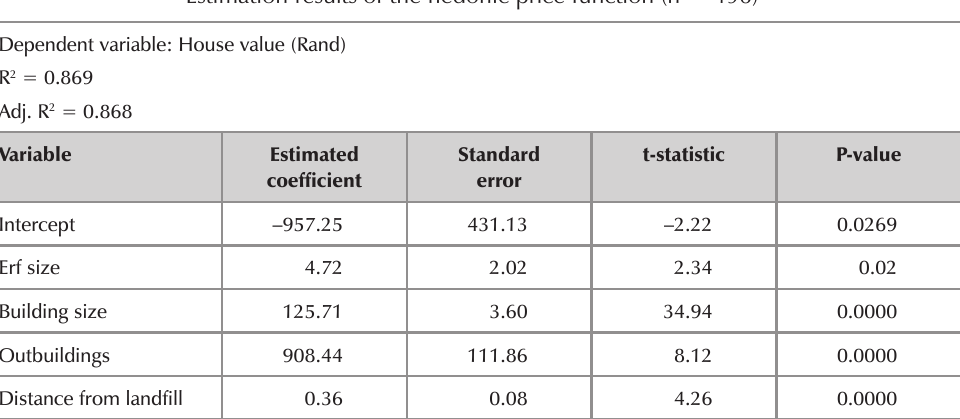
Estimation results of the hedonic price function (n =